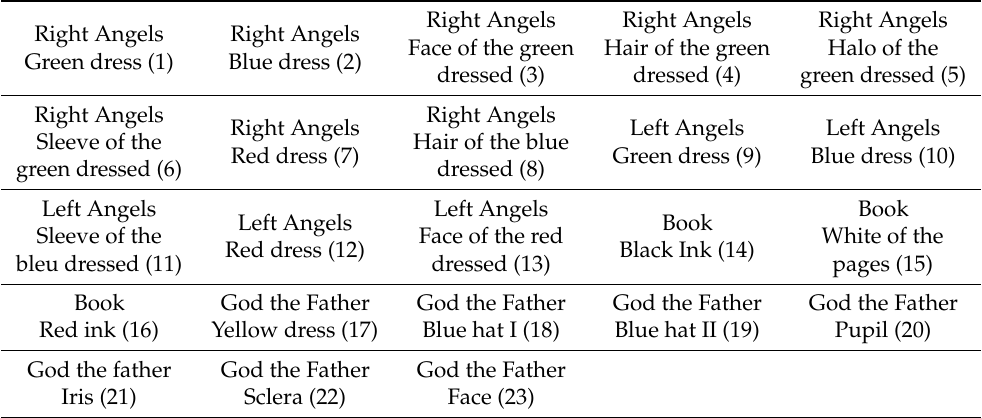
Table 2. Points of the gable of San Diego where the punctual XRF spectra have been collected. The numbers between the parentheses refer to Figure 1 (from 20 to 23) and Figure 2 (1 to